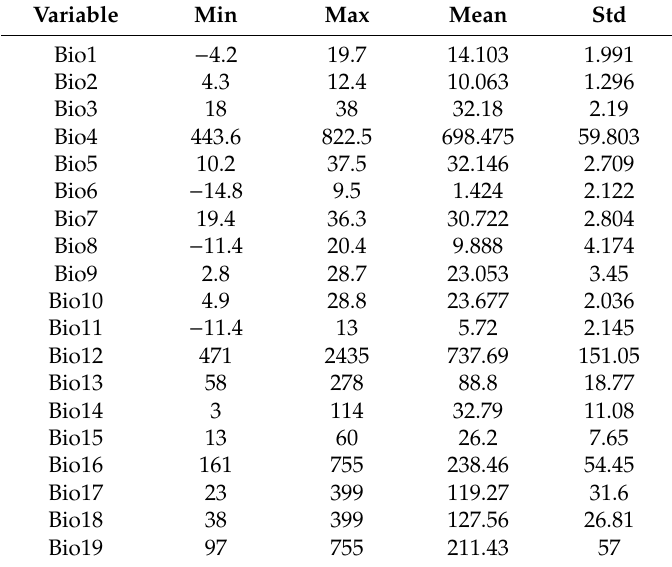
Table A4. 19 Bioclimatic variables of 2070 RCP4.5 scenario (see Figure 1 for variables